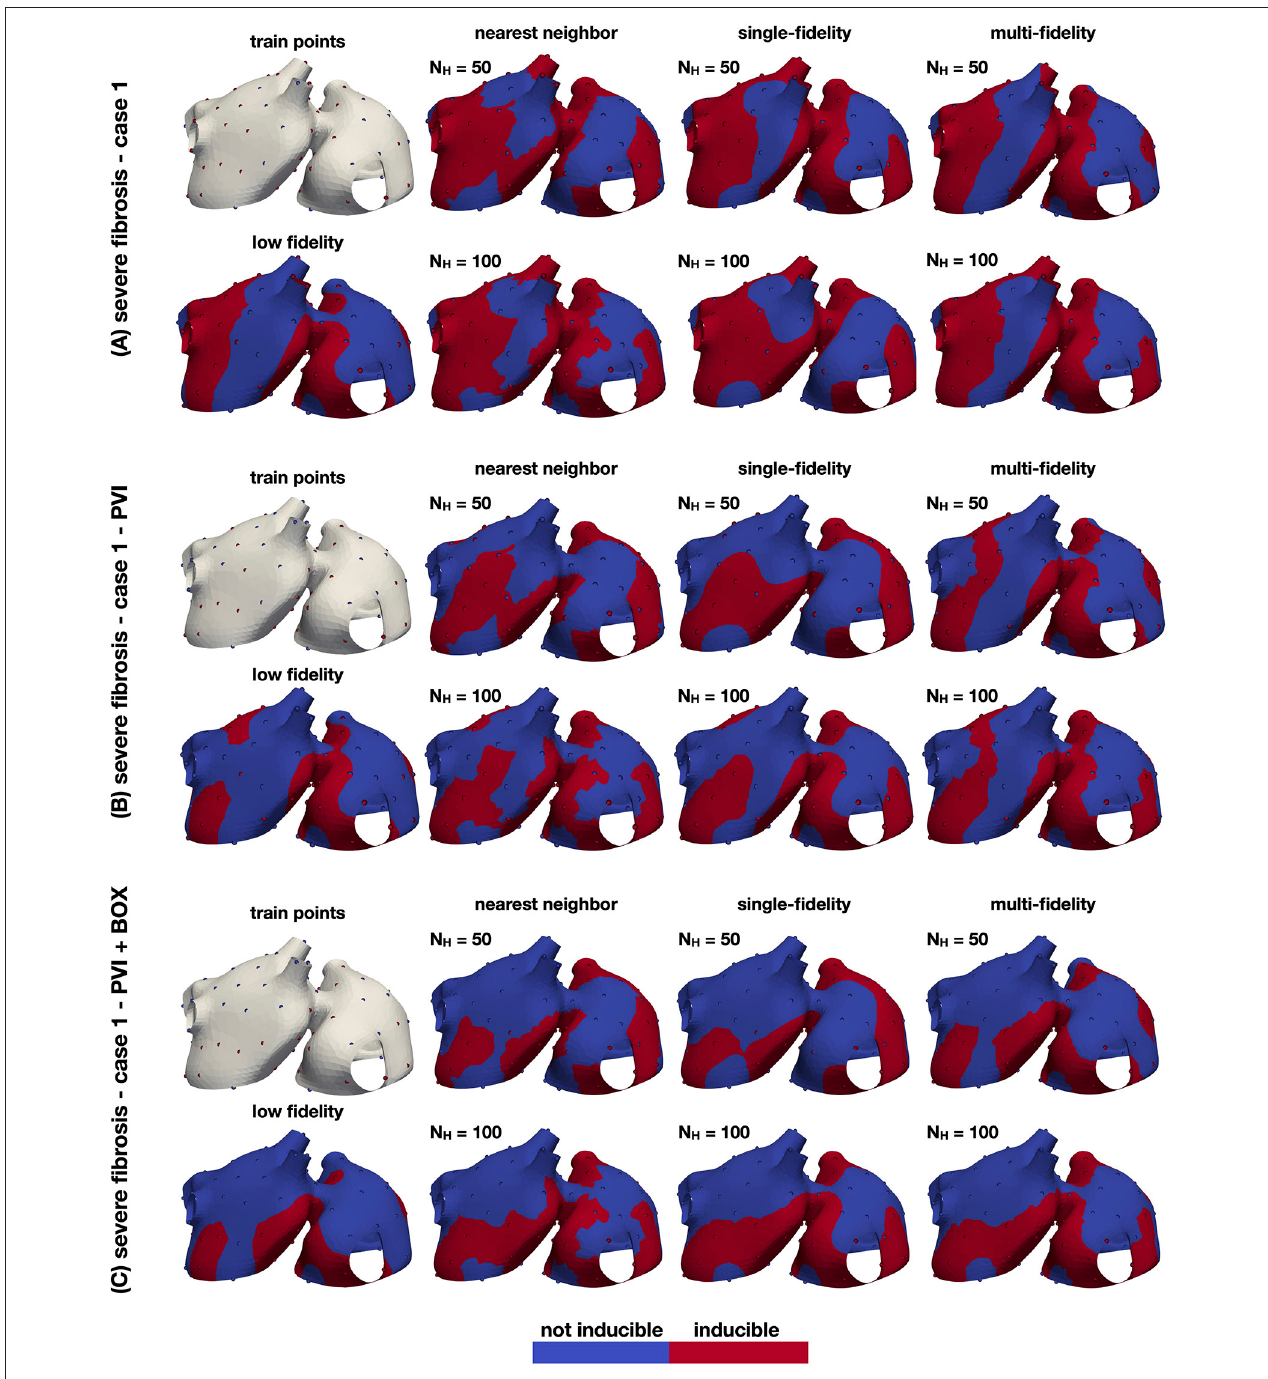
FIGURE 6 | Inducibility maps for the three cases. The performance of the classifiers is analyzed for three cases: a case with no ablation (A) , a case with PVI ablation (B) and a case with PVI+BOX ablation (C) . In each panel, the leftmost column shows the training set (top) and the single-fidelity Gaussian process classifier trained with 100 low fidelity samples (bottom). In the remainder panels, we show the nearest neighbor, single-fidelity Gaussian process classifier, and multi-fidelity Gaussian process classifier trained with 50 and 100 high fidelity samples. The ground truth points are also shown in these panels. average, 5.4% points of accuracy comparing to the single- number of simulations that has been used in clinical studies fidelity classifier and 5.7% comparing to the nearest neighbor to optimize the ablation treatment (Boyle et al., 2019). We classifier. Only in one case there was a decrease in observe that by using the multi-fidelity classifier we gain, on